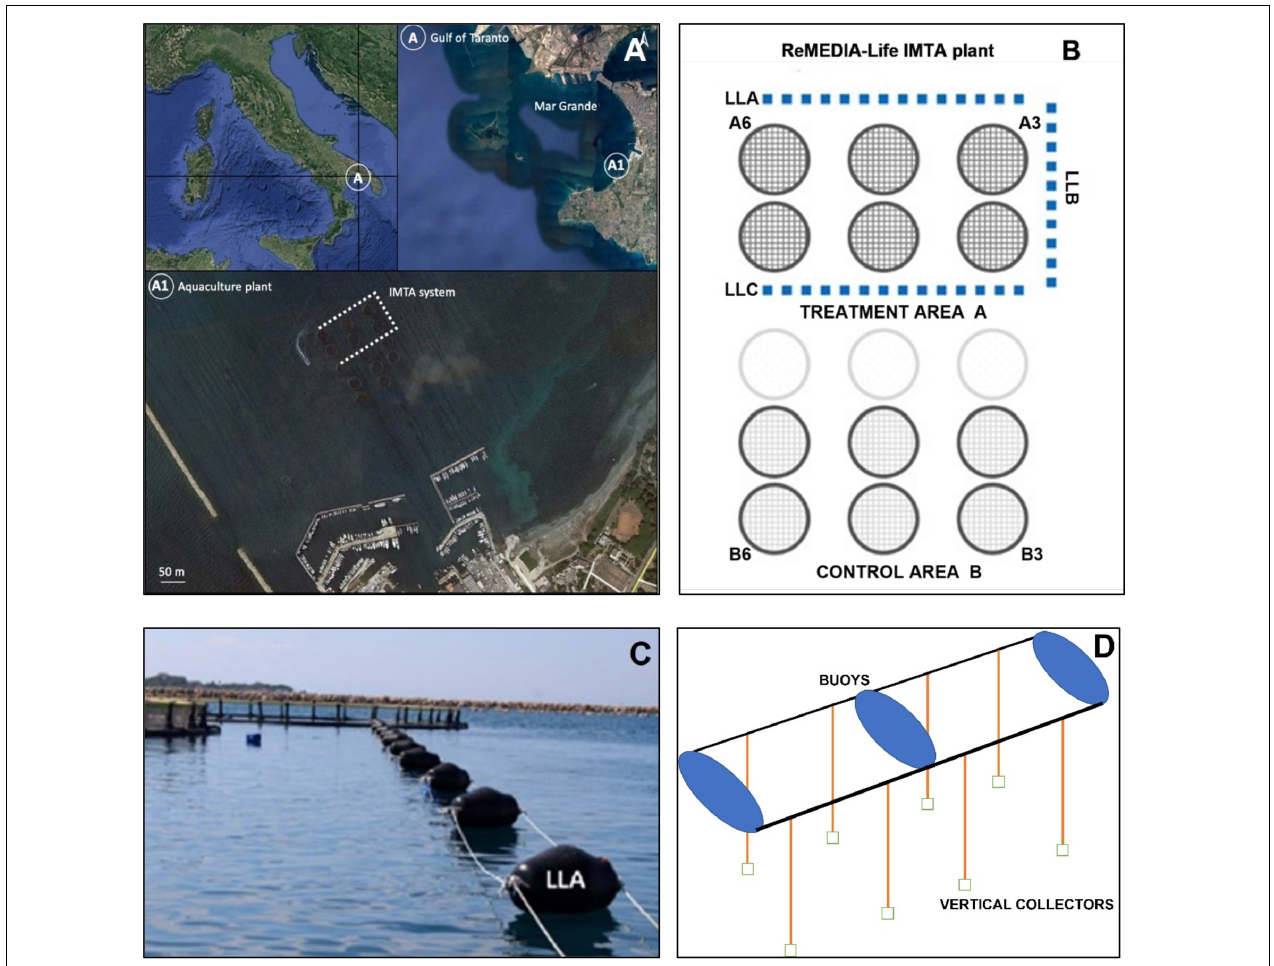
FIGURE 1 | (A) Map of the study site; (B) disposition of the long lines, the blue points represent the three long lines in the area A (treatment area), and the A3, A6, B3, and B6 are indicative of the sampling points of the hard substrate benthic communities; (C) a photograph of the external long line; (D) scheme showing the vertical collectors in two